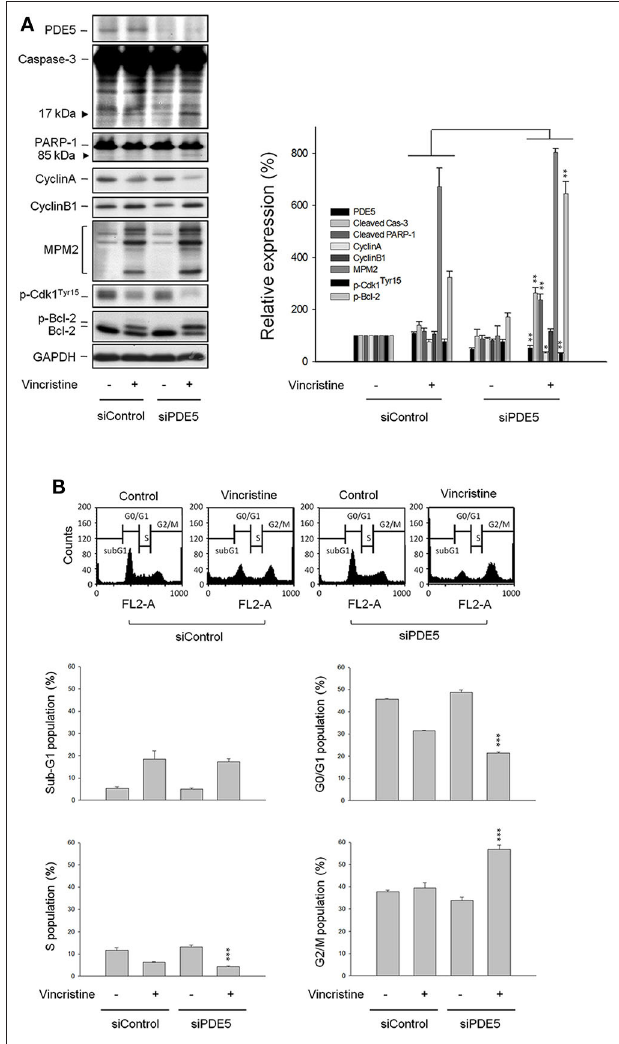
FIGURE 4 | Effect of PDE5 knockdown on vincristine-induced cell-cycle distribution and protein expression. PC-3 cells were transfected with control or PDE5 siRNA as described in the Materials and methods section. After the transfection, the cells were incubated in the absence or presence of vincristine (10nM) for 24h and then the cells were harvested and lysed for the detection of protein expression by Western blot analysis (A) or the cells were harvested for propidium iodide staining to analyze the distribution of cell populations at various phases using FACScan flow cytometric analysis (B) . Data are expressed as mean ± SEM of four independent determinations. * P < 0.05, ** P < 0.01, *** P < 0.001 compared with vincristine alone at siControl